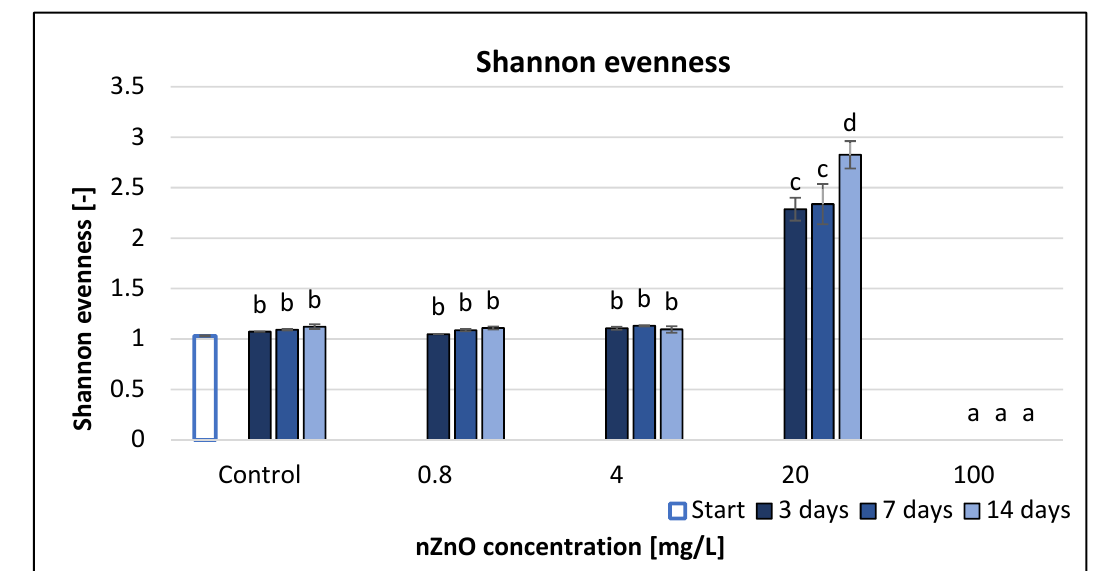
Figure 5. The effect of ZnO nanoparticles on freshwater Shannon evenness value. Letters on the columns indicate significant differences (level of significance: p < 0.05).